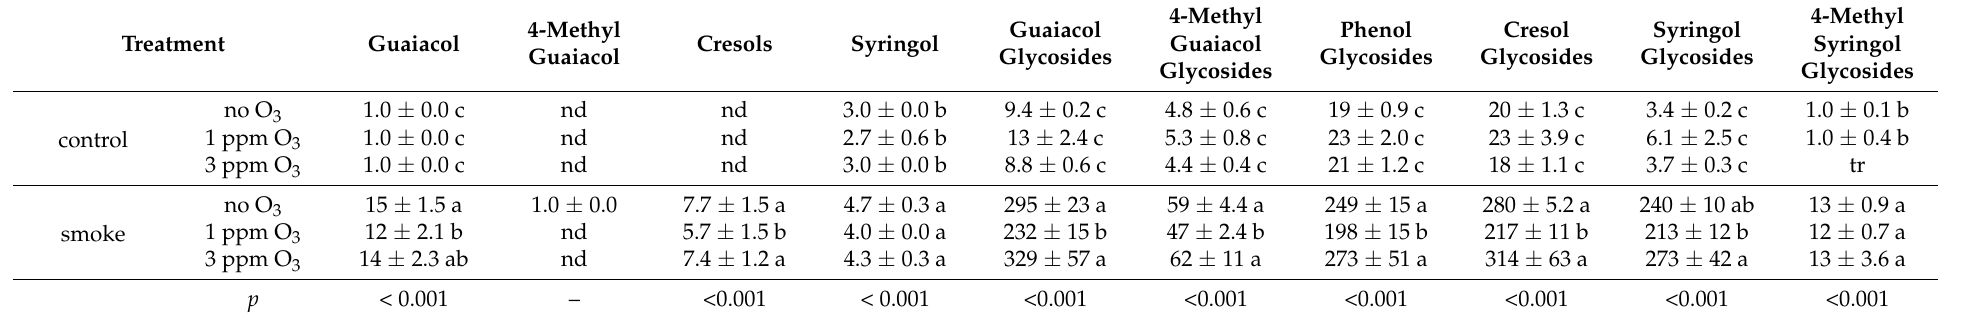
Values are means of three replicates ( n = 3) ± standard deviation. Different letters (within columns) indicate statistical significance ( p = 0.05, one way ANOVA); ns = not significant. Smoke exposure occurred at approximately 7 days post-veraison. Table 3. Concentration ( µ g/L) of volatile phenols and volatile phenol glycosides in wines made from control and smoke-affected grapes, with and without post-harvest ozone treatment (at 1 ppm for 24 h or 3 ppm for 12 h).